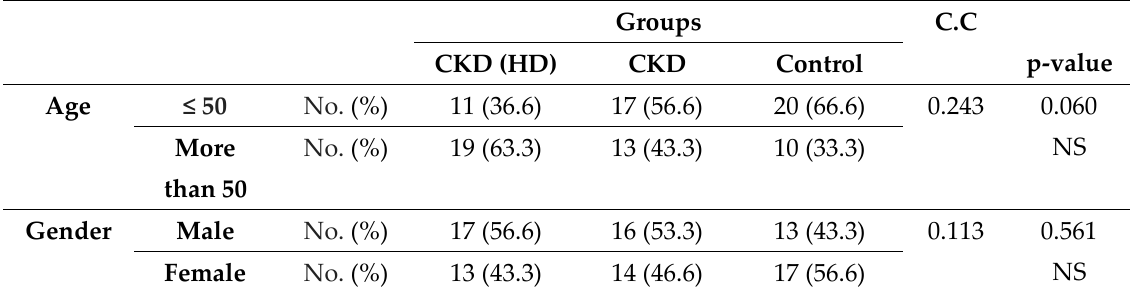
Table 1: Distribution of CKD patients and control groups according to age and